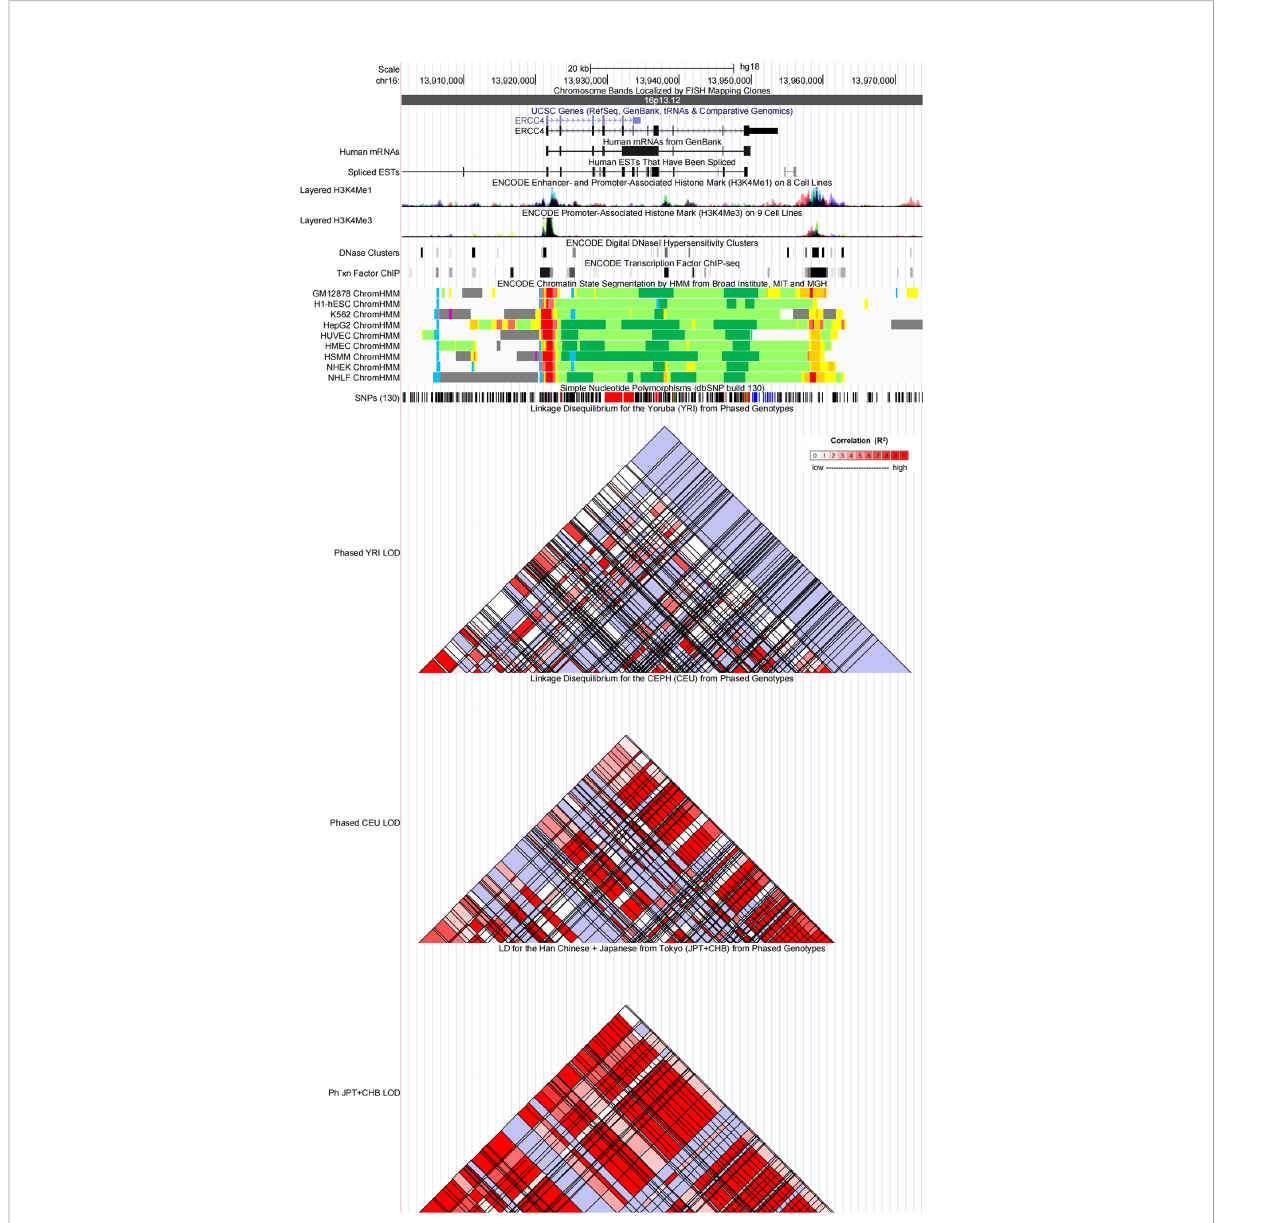
FIGURE 3 Evidence from the Encyclopedia of DNA Elements (ENCODE) data for the regulatory function of variants in 16p13.12 using the UCSC Genome Browser. The plot represents 16p13.12 within a 20-kb window centered on the ERCC4 gene region. Tracks (from top to bottom) in each of the plots are Genome Base Position, Chromosome Bands, UCSC Genes, Human messenger RNAs from GenBank, Human expressed sequence tag (ESTs) That Have Been Spliced, ENCODE Enhancer and Promoter-Associated Histone Mark (H3K4Me1) on 8 Cell Lines, ENCODE Promoter- Associated Histone Mark (H3K4Me3) on 9 Cell Lines, ENCODE Digital DNaseI Hypersensitivity Clusters, ENCODE Transcription Factor ChIP-seq, ENCODE Chromatin State Segmentation by Hidden Markov Model (HMM) from Broad Institute (bright red, active promoter; light red, weak promoter; purple, inactive/poised promoter; orange, strong enhancer; yellow, weak/poised enhancer; blue, insulator; dark green, transcriptional transition/elongation; light green, weak transcribed; gray, polycomb-repressed; light gray, heterochromatin/low signal/repetitive/copy number variation), Simple Nucleotide Polymorphisms (dbSNP build 130), Linkage Disequilibrium for the Yoruba (YRI) from Phased Genotypes, Linkage Disequilibrium for the CEPH (CEU) from Phased Genotypes and LD for the Han Chinese + Japanese from Tokyo (JPT+CHB) from Phased